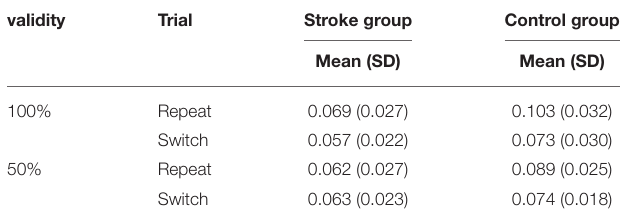
TABLE 4 | Participants’ efficiency scores (%/ms) of repeat and switch trials in task-switching paradigm stratified by group and validity.